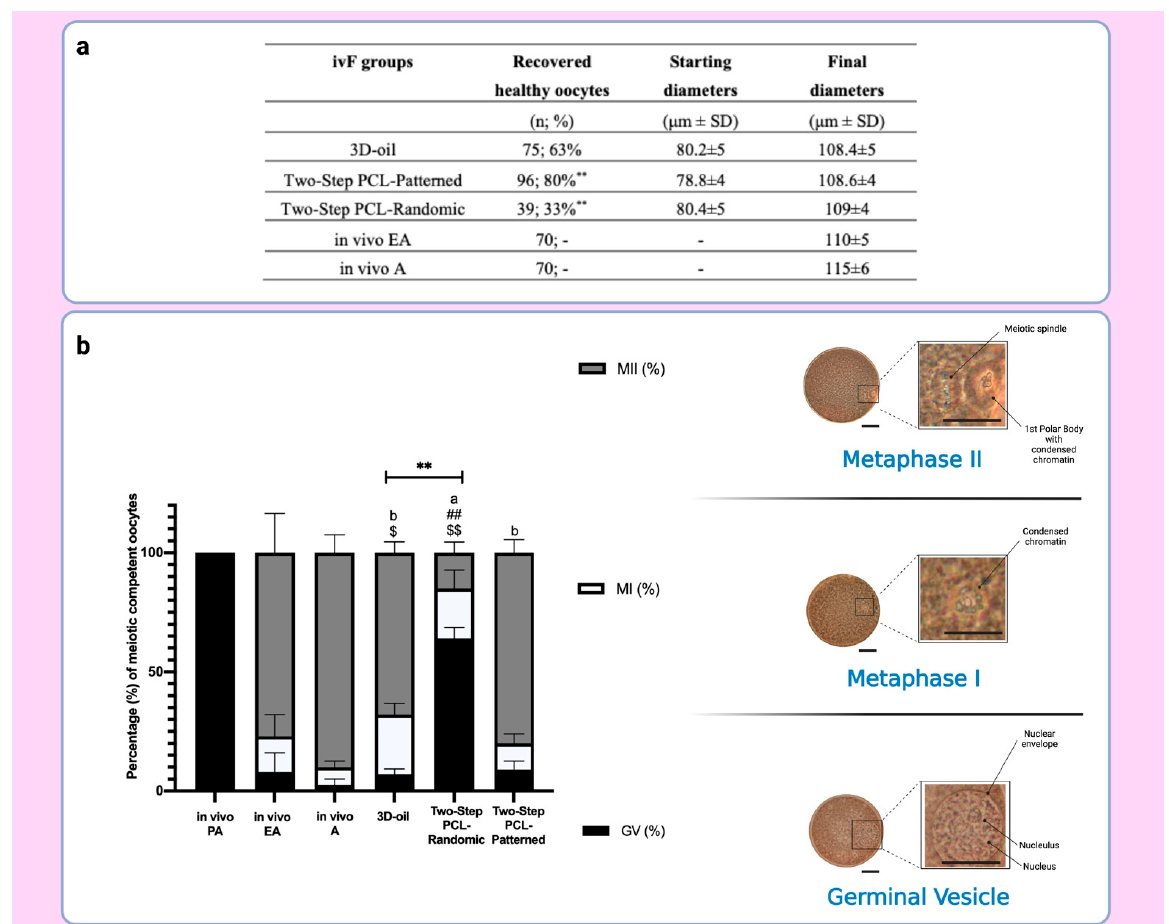
Figure 8. ( a ) Table summarizing the number of recovered healthy oocytes and their mean diameters at the end of ivF culture. **: statistically significant vs. 3D-oil group. ( b ) On the left: Percentage of the oocyte meiotic competence acquired in vitro. Different nuclear stages were characterized. a,b : statistically significant vs. recovered healthy oocytes from in vivo PA ( p < 0.05 and p < 0.01, respectively); ##: statistically significant vs. recovered healthy oocytes from in vivo EA ( p < 0.01); $, $$: statistically significant vs. recovered healthy oocytes from in vivo A ( p < 0.05 and p < 0.01, respectively); **: statistically significant vs. recovered healthy oocytes from 3D-oil group ( p < 0.01). Data in which subscripts are not indicated, were considered not statistically significant. On the right: Images of oocyte nuclear stages. GV: Germinal Vesicle Break Down; MI: Metaphase 1; MII: